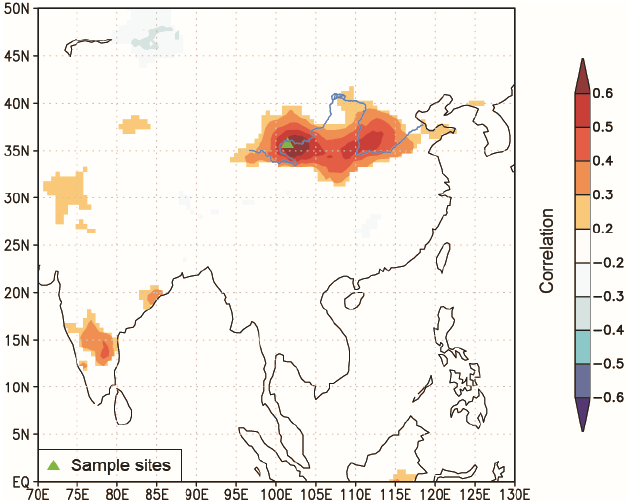
Figure 6. Spatial correlations between the residual chronology and the gridded previous August–June precipitation (CRU TS 4.04) for the period 1958–2013.